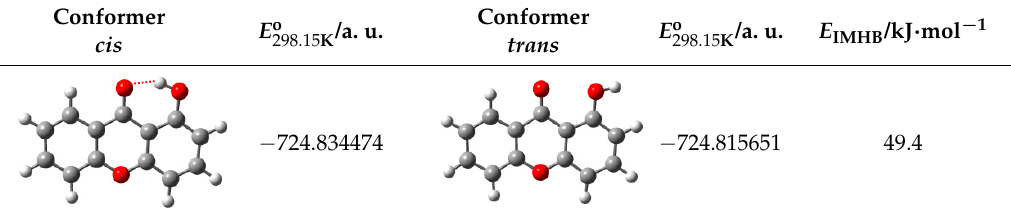
(cid:2925) , (cid:2925) , K K , 298.15K